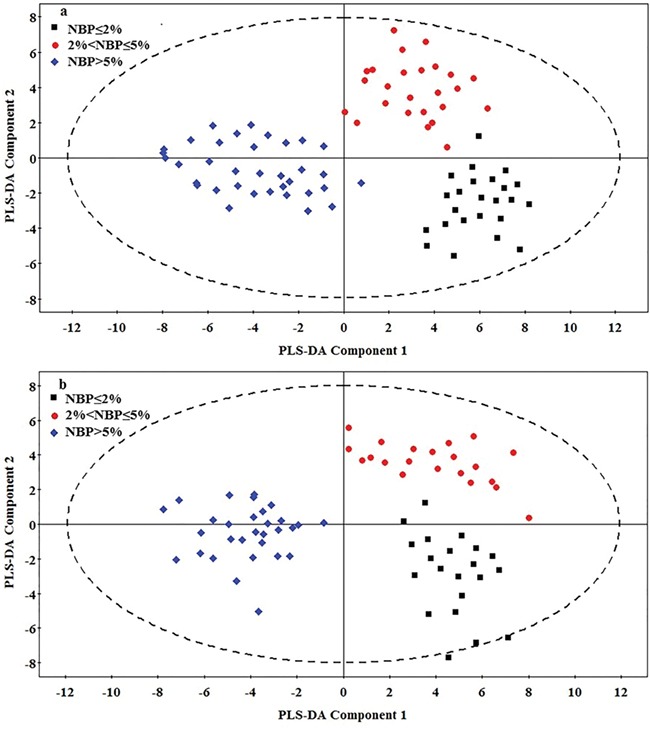
PLS-DA score plot of serum metabolic profiles of Asian short-toed Lark (C. cheleensis) nestlings hatched during periods of high (>5%), moderate (between 2 and 5%) and low (≤ 2%) grasshopper nymph abundance (NBP) in 2016 (a) and 2017 (b).